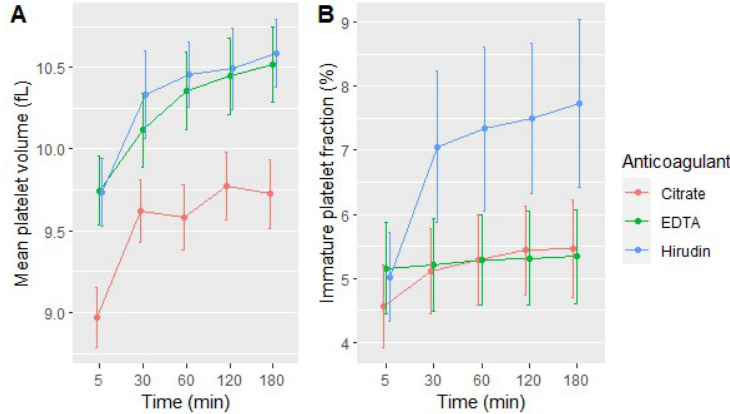
Figure 4. Mean platelet volume ( A ) or mean immature platelet fraction ( B ) according to the time elapsed between blood draw and analysis. Red lines represent tests performed with blood samples anticoagulated with citrate, green lines with EDTA and blue lines with hirudin. Bars represent 95% CI of the mean. Table 1. Effect of the time elapsed between blood draw and MPV measurement (expressed in fL) for each anticoagulant. Measurements at five minutes after blood draw are used as the reference. Mean difference, relative difference (%) and 95% confidence interval for the mean difference are given for each value.